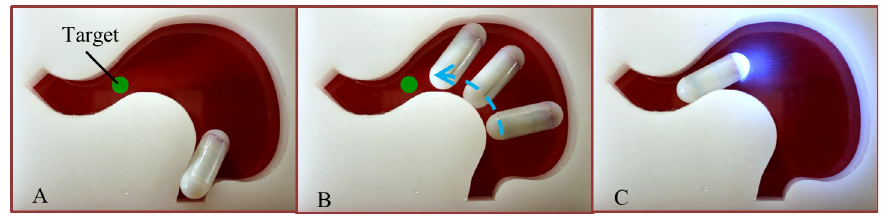
Fig 13. Reed switch controlled by EMA verification. (A) Starting position of the capsule with LED OFF. (B) Overlapped picture of the capsule’s movement while maintaining the LED state. (C) Capsule reaches the target and the reed switch is activated, thereby turning LED